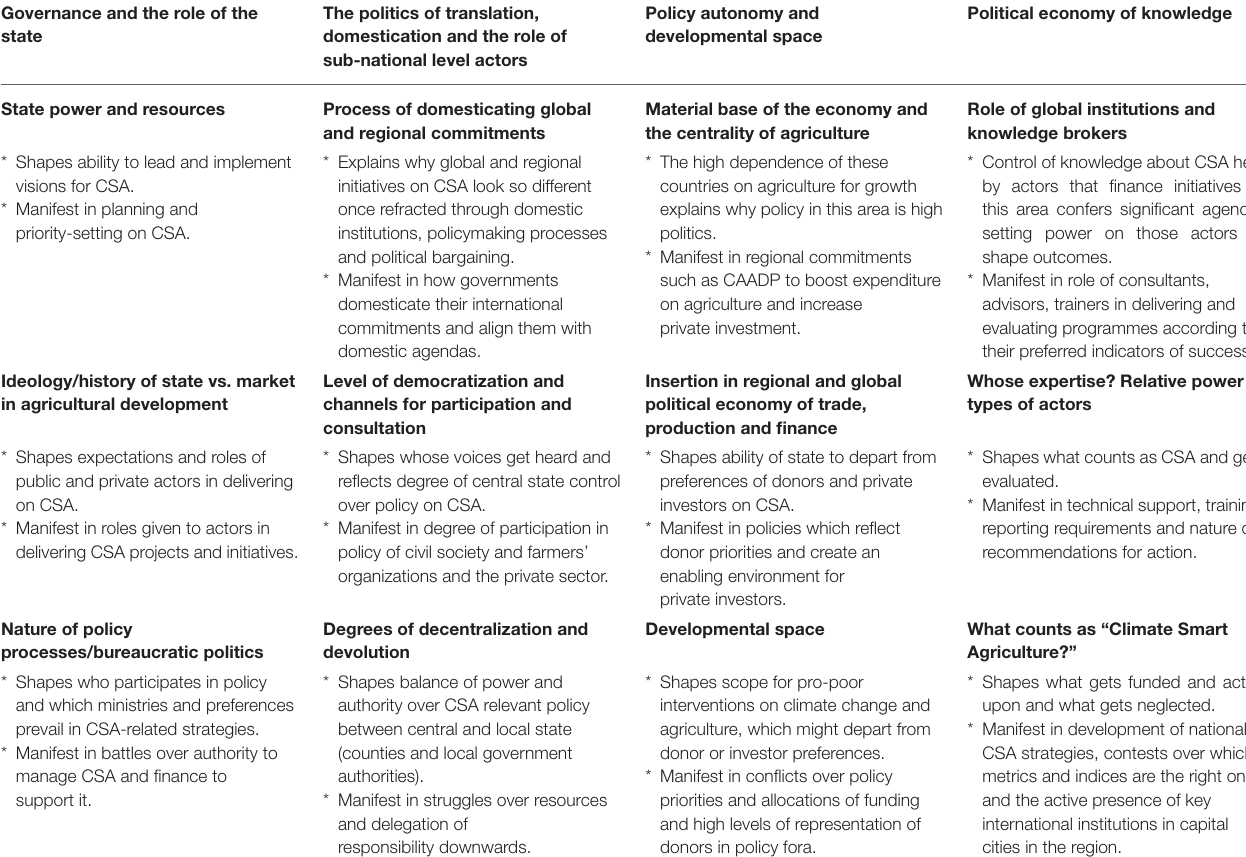
TABLE 1 | A framework for understanding the governance of